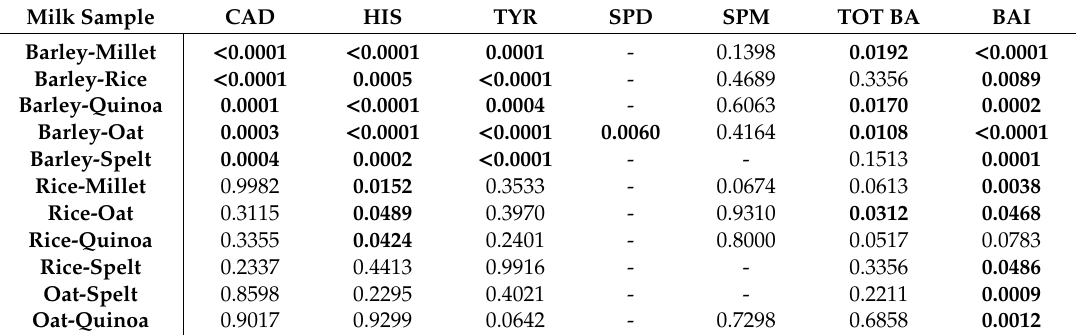
Table 3. One-way ANOVA: p -values 1 .